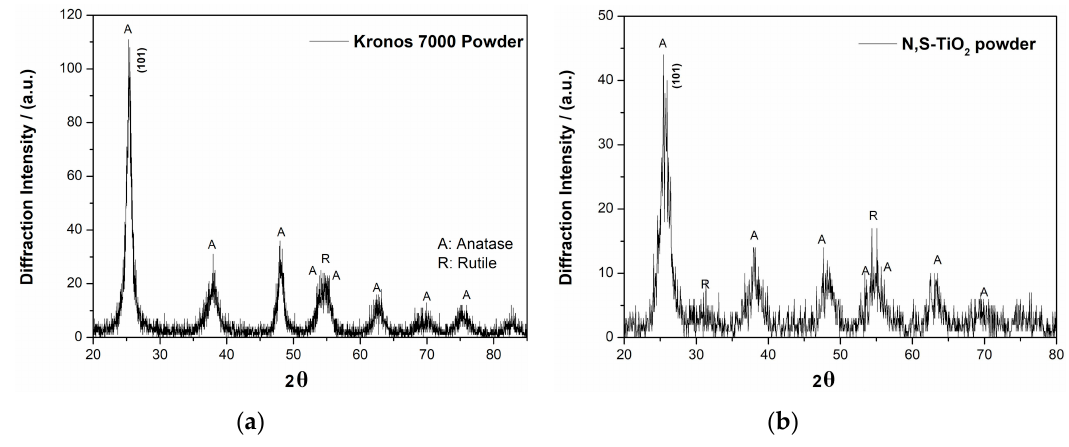
Figure 2. X-ray diffraction patterns of doped ( a ) Kronos vlp 7000 and ( b ), N,S-TiO 2 powders.